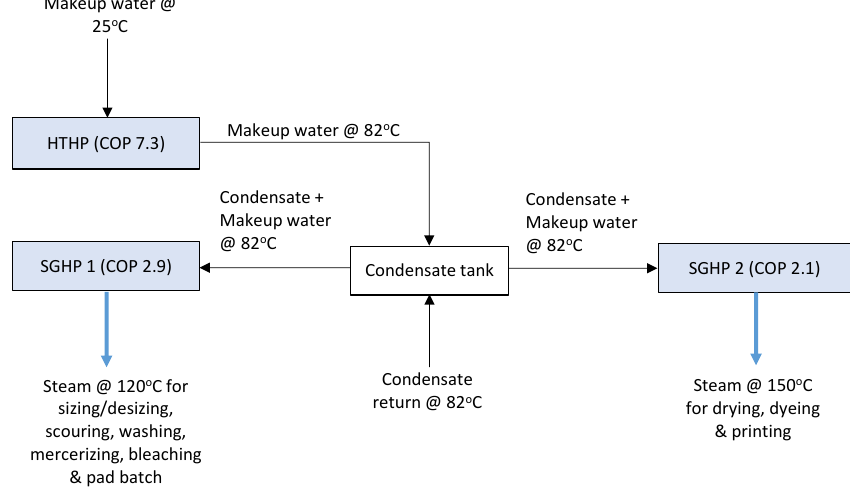
Figure 6. Industrial heat pump applications for textile wet-processing.